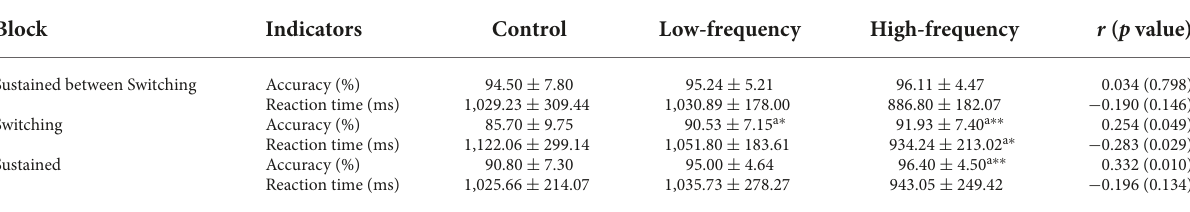
TABLE 5 The accuracy and reaction time of the Switching Task in each group (Mean ±